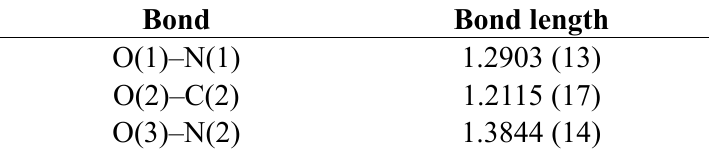
Table 1. Selected bond lengths (Å) for 1